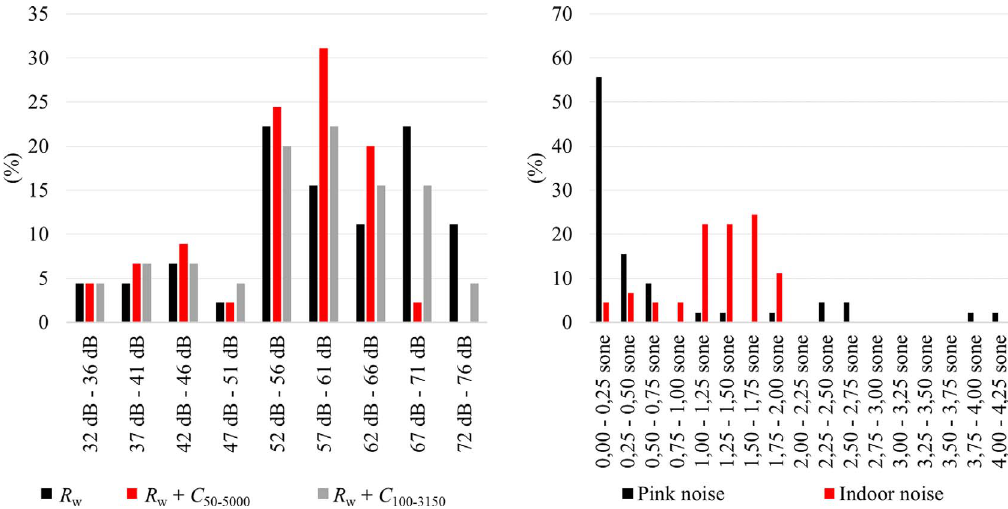
Figure 4. Histogram of the distribution of the walls over different R w , R w + C 50 – 5000 and R w + C 100 – 3150 quali fi ers (left), and over different Loudness values (right). Table 1. Description of the evaluated SNQ ’ s (see also Fig. 2 for spectrum adaptation terms). The upper fi ve are already in use. Symbol Description R